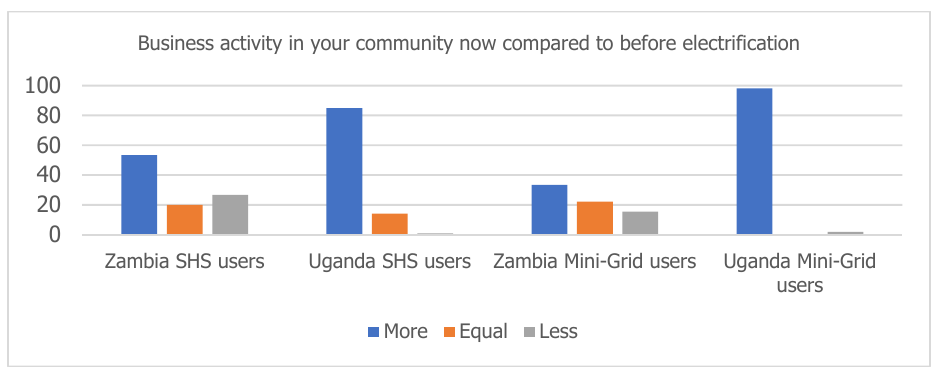
Figure A7. Impact of electrification on business activity among various subgroups; Responses in %.